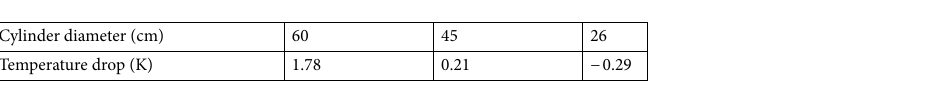
Table 2. The effect of cylinder diameter on the temperature drop at 90 cm height compared to that at 10 cm height for an insulated air column.